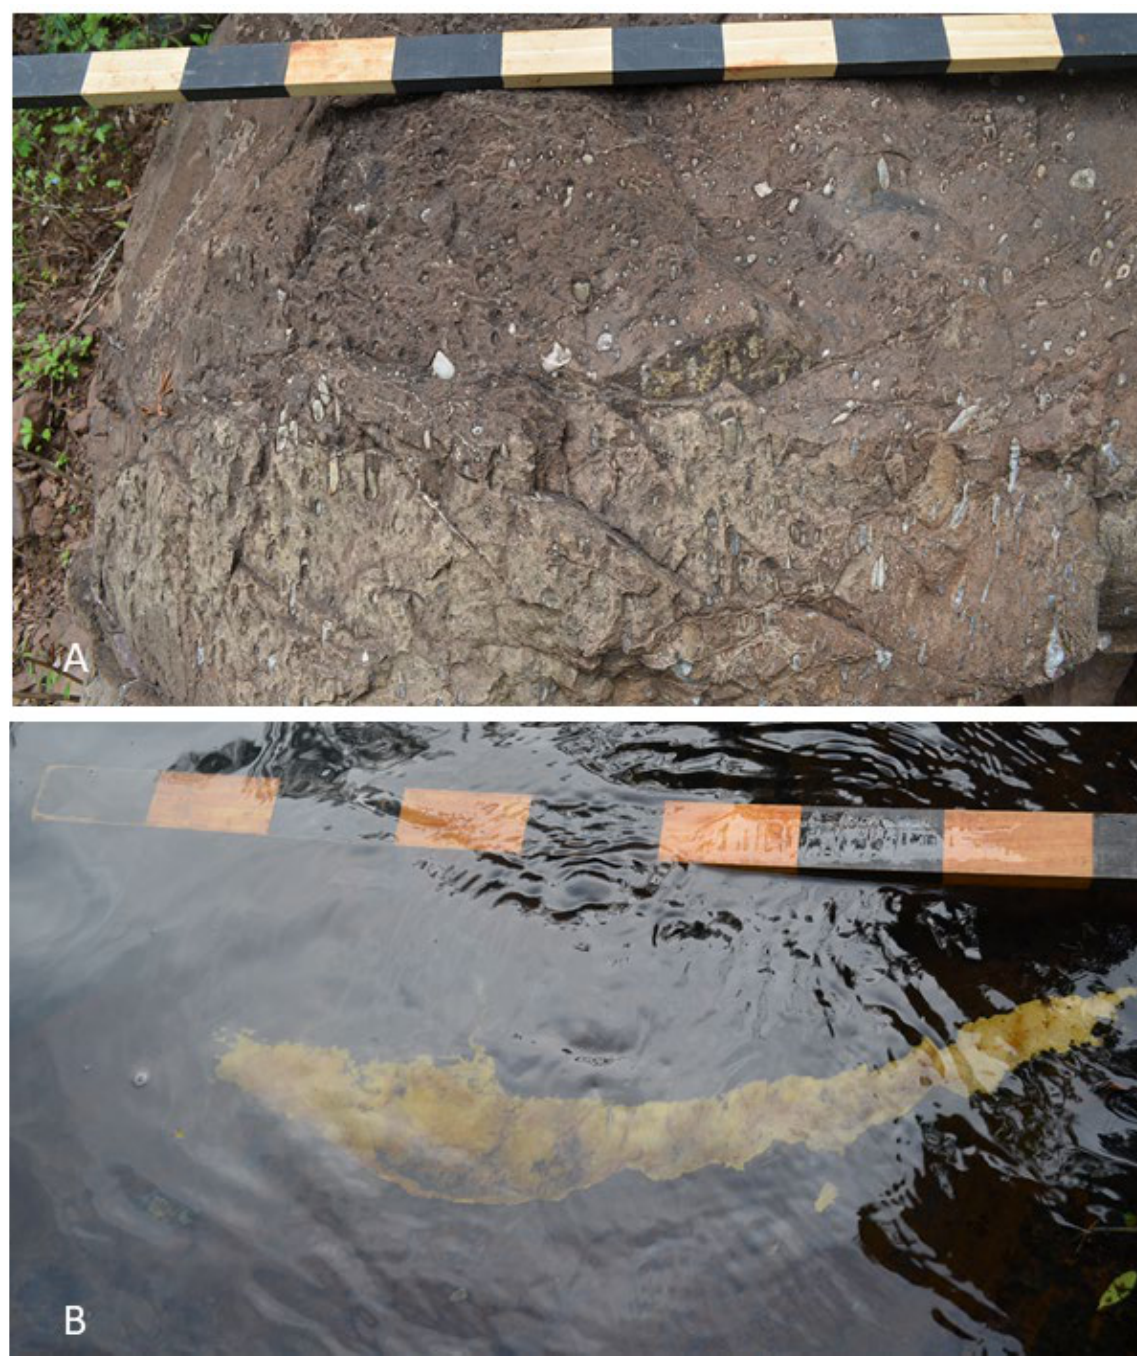
Figure 12. A: amygdales of quartz included in the basalts (Abdon Batista County, Santa Catarina). B: non- translucent tabular nodule of chert (white) included in the bed of the Santa Bárbara stream (Bom Jardim da Serra County). The scale has painted segments, each one of 10 cm